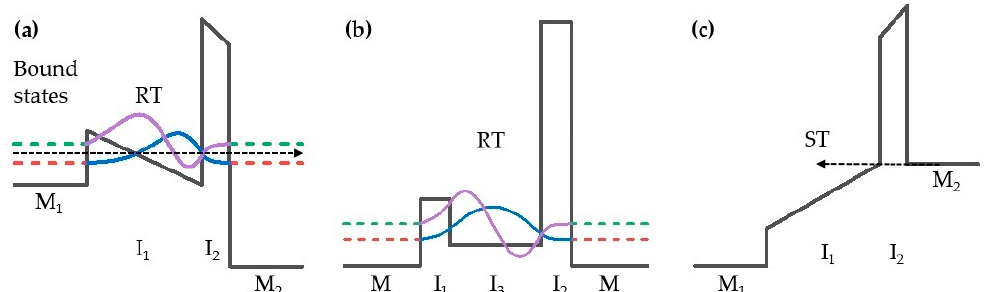
Figure 5. Schematics of band alignment for: ( a ) MI 2 M diode under positive bias on metal 2 showing bound states in a quantum well and conditions for resonant tunneling to occur; ( b ) MI 3 M diode under zero bias, depicting existence of bound states in a deep quantum well; ( c ) MI 2 M diode under negative bias on metal 2 and conditions of step tunneling.